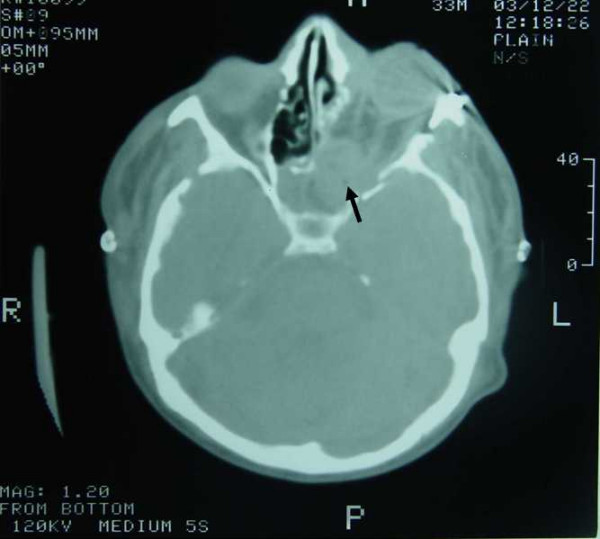
Postoperative CT. Postoperative CT scan of the patient showing total excision of the tumor and the presence of free temporalis graft in the ethmoid and sphenoid sinus (arrow).